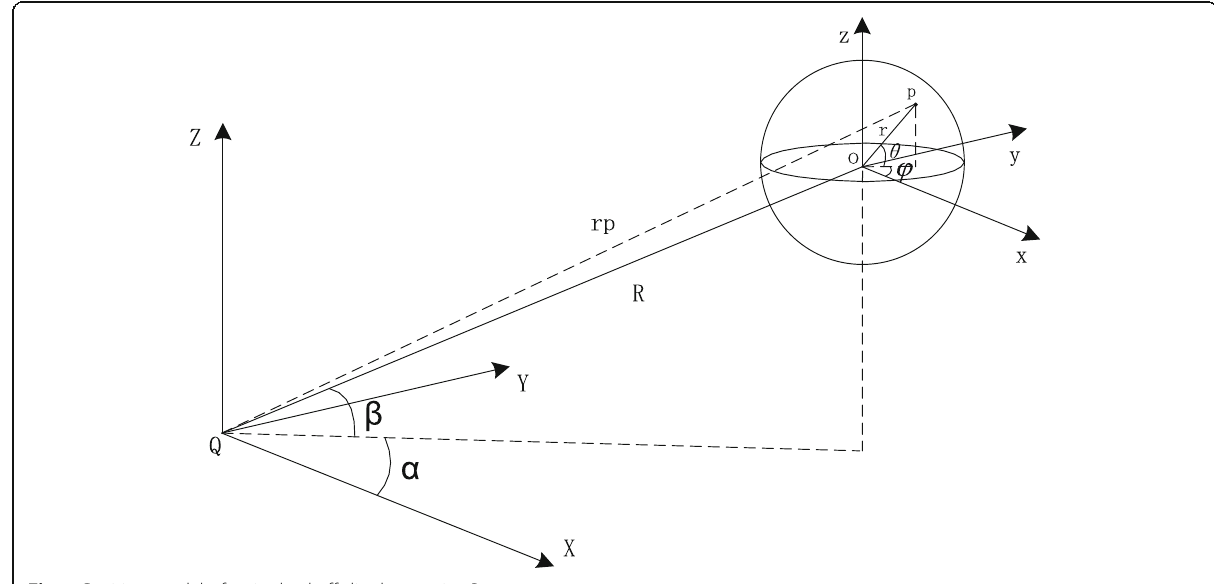
Fig. 1 Position model of a single chaff dipole at point